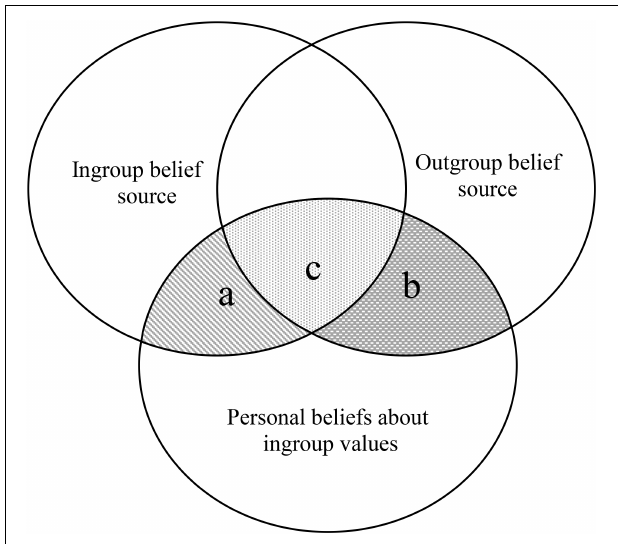
FIGURE 1 | Visual representation of FICK: relations among personal beliefs and the ingroup and outgroup source beliefs.